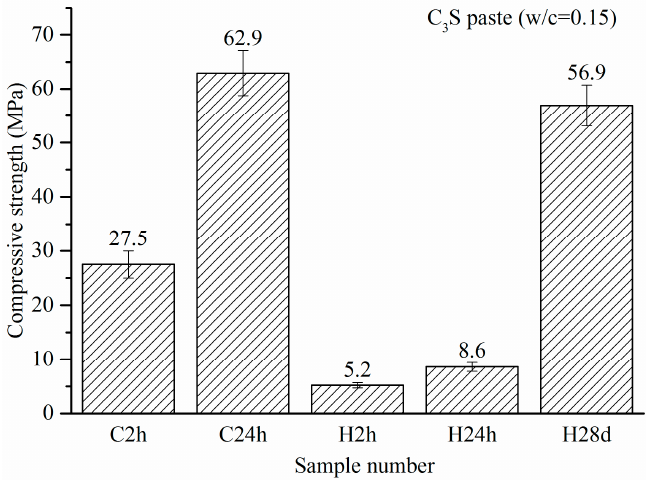
Figure 7. Compressive strengths of carbonation and hydration C 3 S pastes.